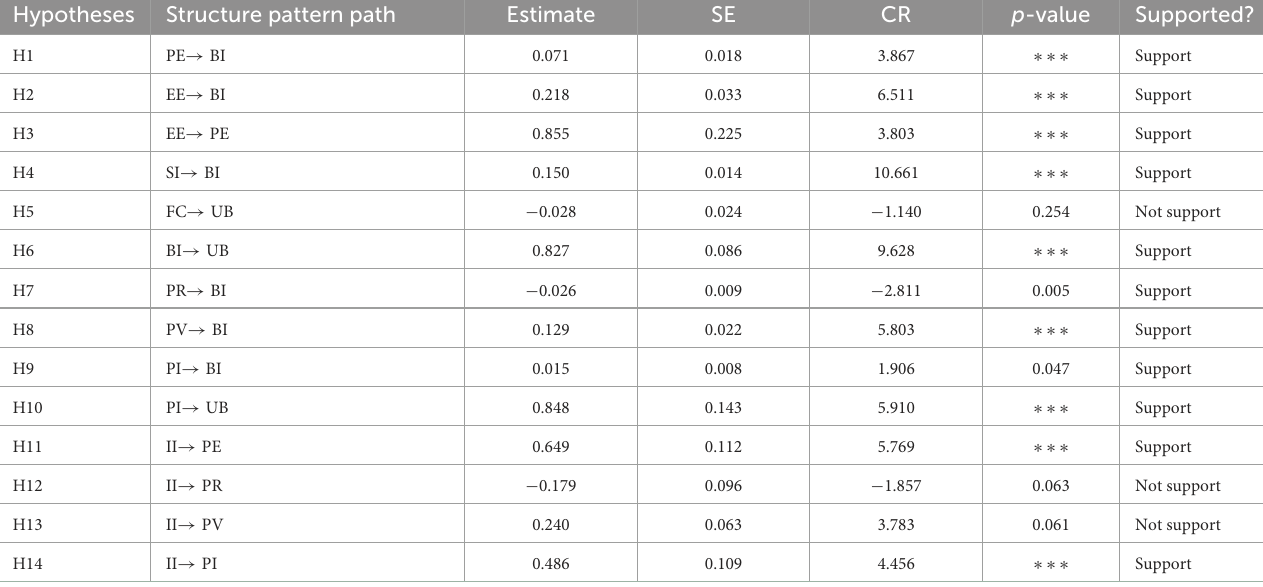
TABLE 4 Path analysis and detection results of the structural